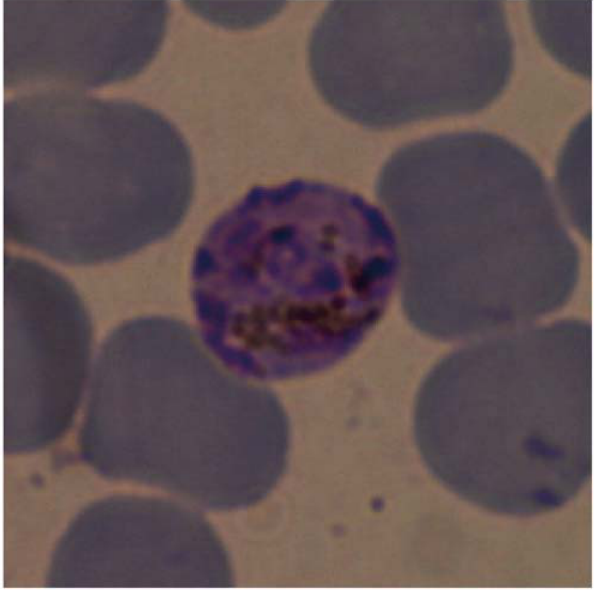
Figure 1. Giemsa-stained thin blood smear showing an immature schizont.